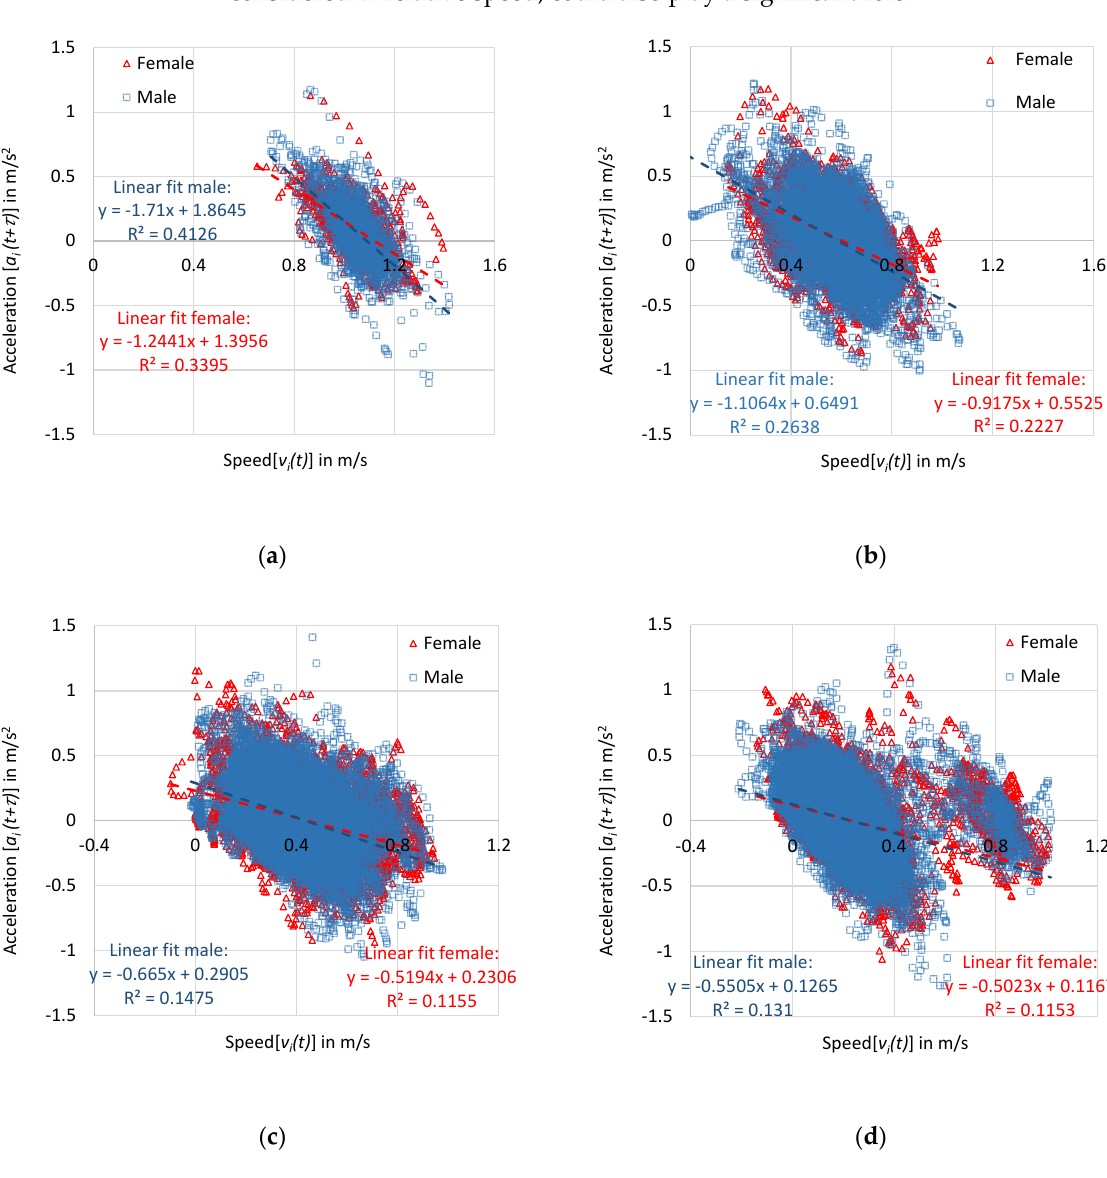
Figure 5. Instantaneous speed versus time-delayed instantaneous acceleration plots for different density levels: ( a ) N = 14; ( b ) N = 20; ( c ) N = 24; ( d ) N = 30. As verified with the t -test, the slopes of the regression lines for males and females were significantly different for all cases. The test statistics, i.e., ( t-stat , p ), for N = 14, N = 20, N = 24, and N = 30 scenarios were (7.138, <0.001), (5.512, <0.001), (7.771, <0.001), and (3.576, <0.001), respectively. This outcome indicates that for a given walking speed level, gender has a significant influence on acceleration behavior and the acceleration (and deceleration) capacities are higher for males compared to females.